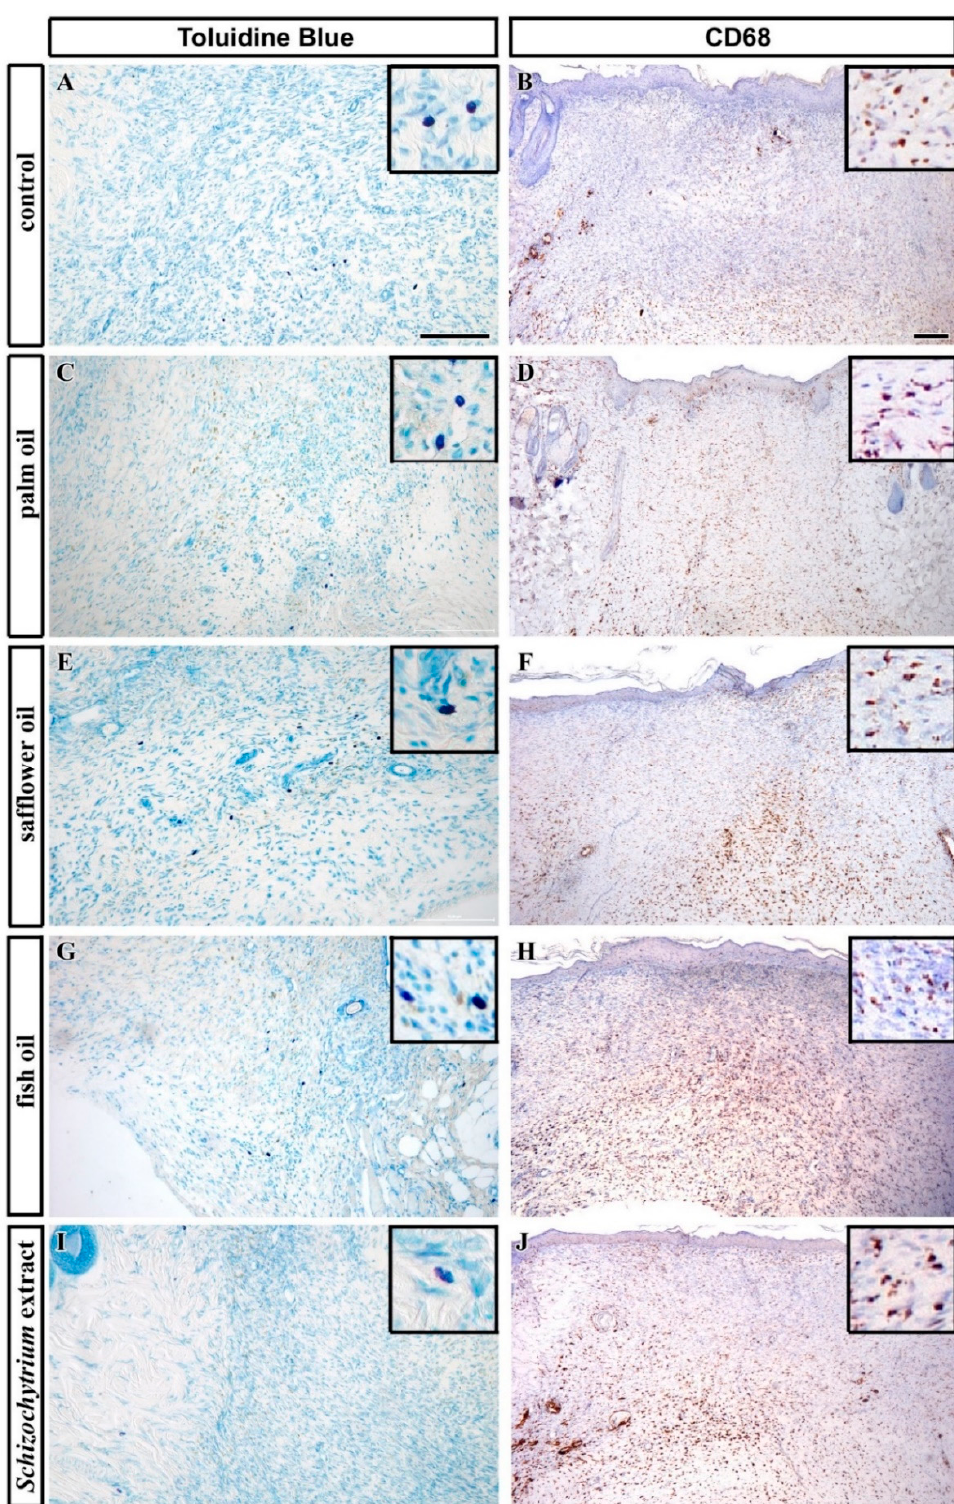
Figure 8. Detection of immune cells in skin of experimental rats 12 days after excision. ( A , B ): Control animals, ( C , D ) palm oil fed animals, ( E , F ) safflower oil, ( G , H ) fish oil, and ( I , J ) Schizochytrium extract treated animals were analyzed 12 days after skin excision. Mast cells labeling by Toluidin Blue staining (blue, photos taken from the middle “B” layer of the dermis; see Figure 14C for the reference) and immunolabeling of macrophages by CD68-positivity (brown, low power view) in transversal sections through the dorsal skin. Inserts display high power images of labeled cells. Scale bar = 100 µm.